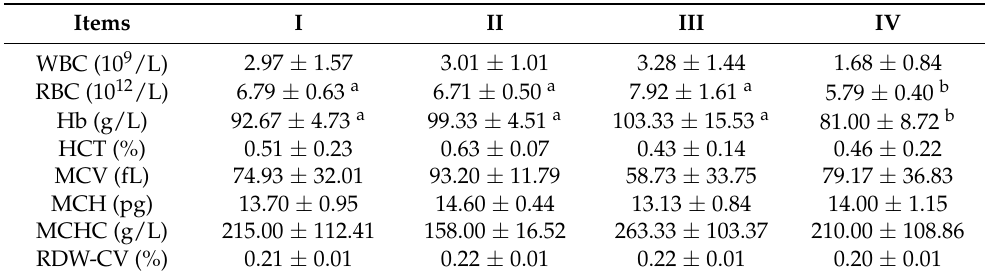
Table 7. Effects of dietary supplementation with different inclusion of SMS-MP on blood physiological indexes of growing sika